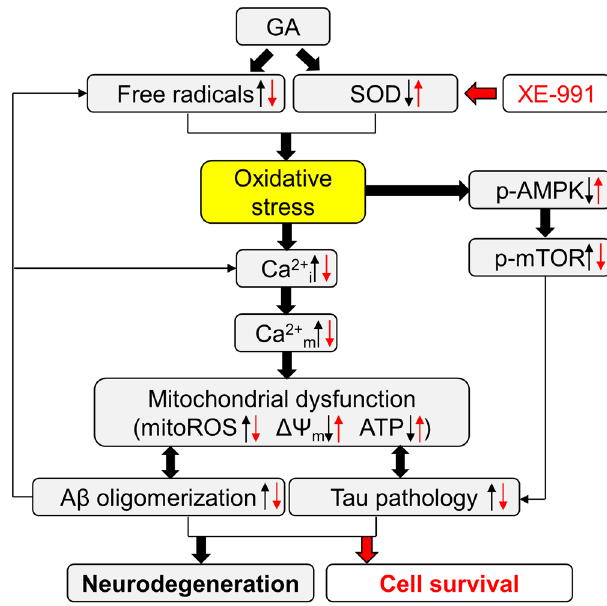
Fig. 8 Working hypothesis showing: (1) how oxidative stress may represent the main driving force contributing to the subsequent complex AD pathogenic cascade, and (2) how the restoration of SOD activity induced by XE-991 may halt this